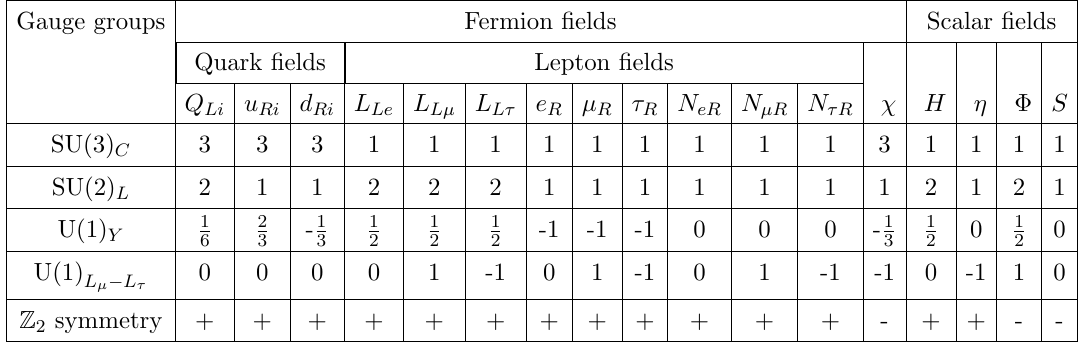
Table 2 . Gauge quantum numbers and Z 2 parity of di(cid:11)erent SM and BSM